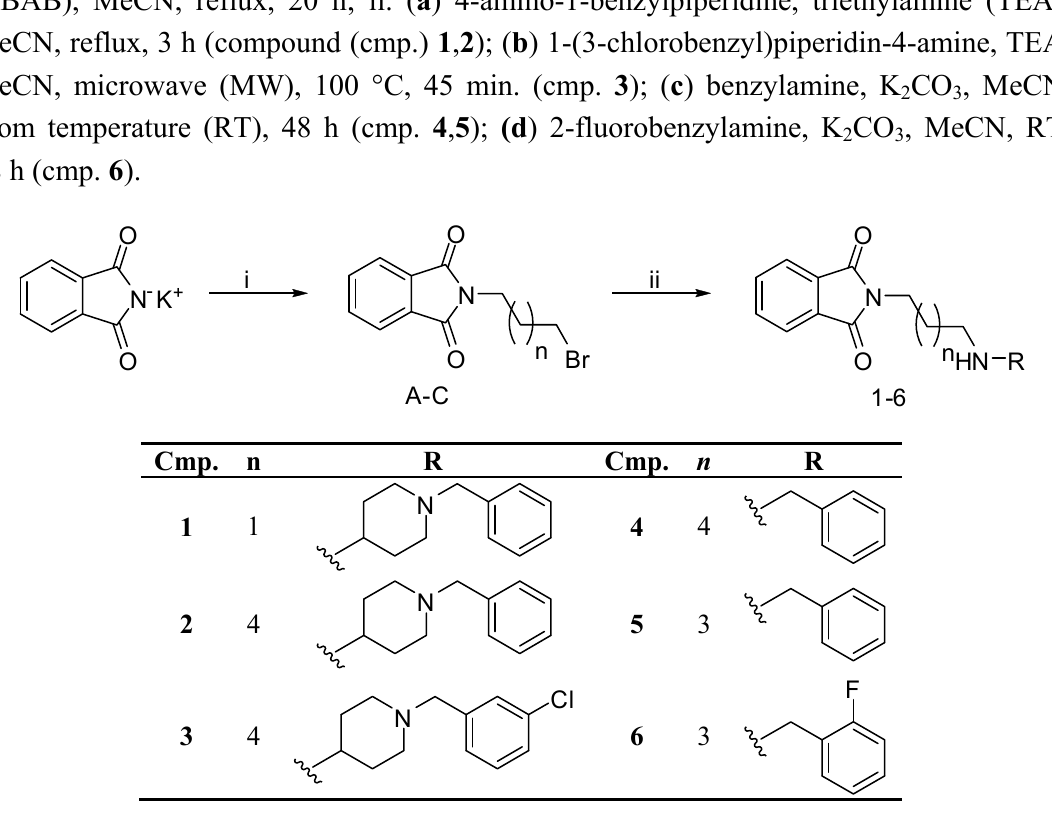
CO , MeCN, 2 3 CO , MeCN, RT, 2 3